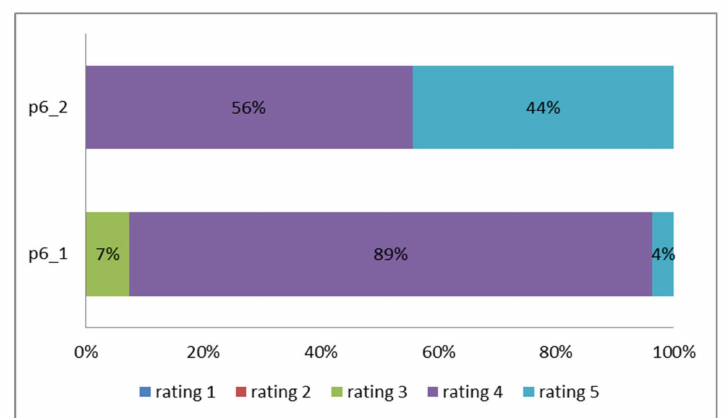
Figure 7. Assessment of the prospect of implementing a CE in the coal power